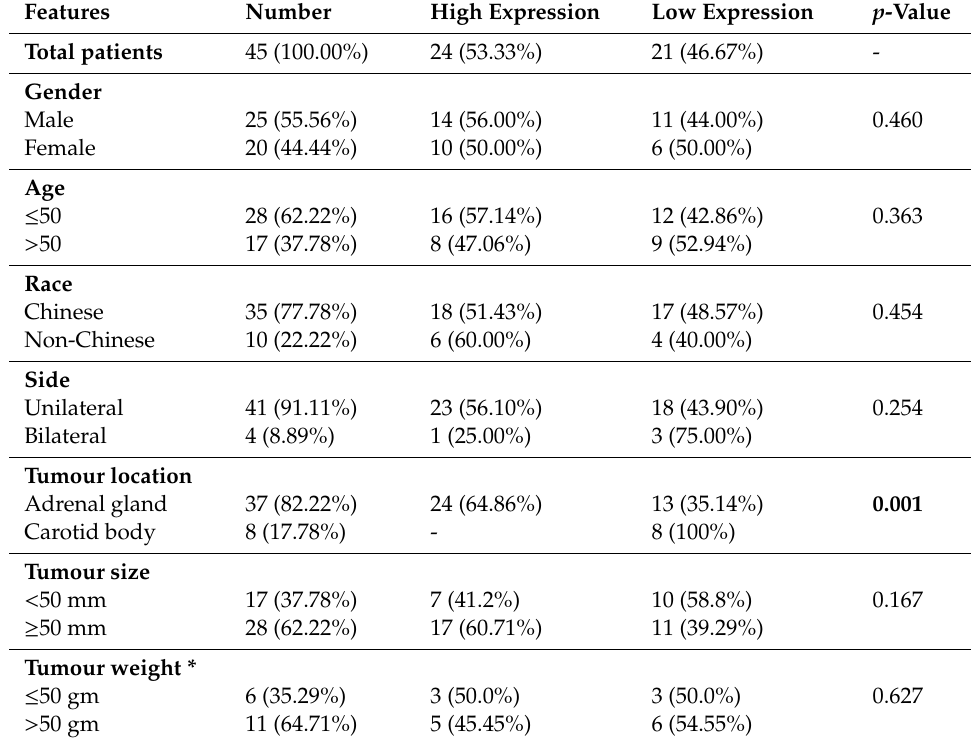
Table 4. Association of EPAS1 mRNA changes with clinicopathological features of patients with pheochromocytoma and